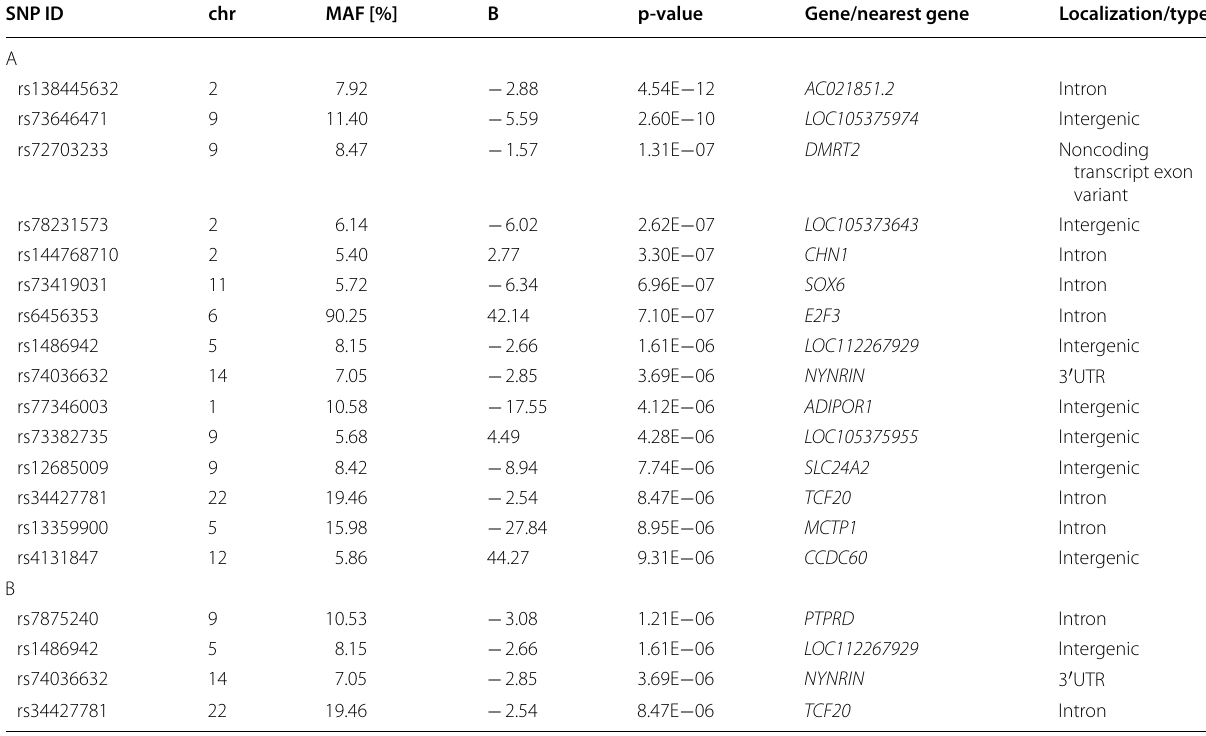
Table 4 The list of variants localized to genes associated with BMI (A) and GWG (B) in ARIC cohort SNP ID chr MAF [%]